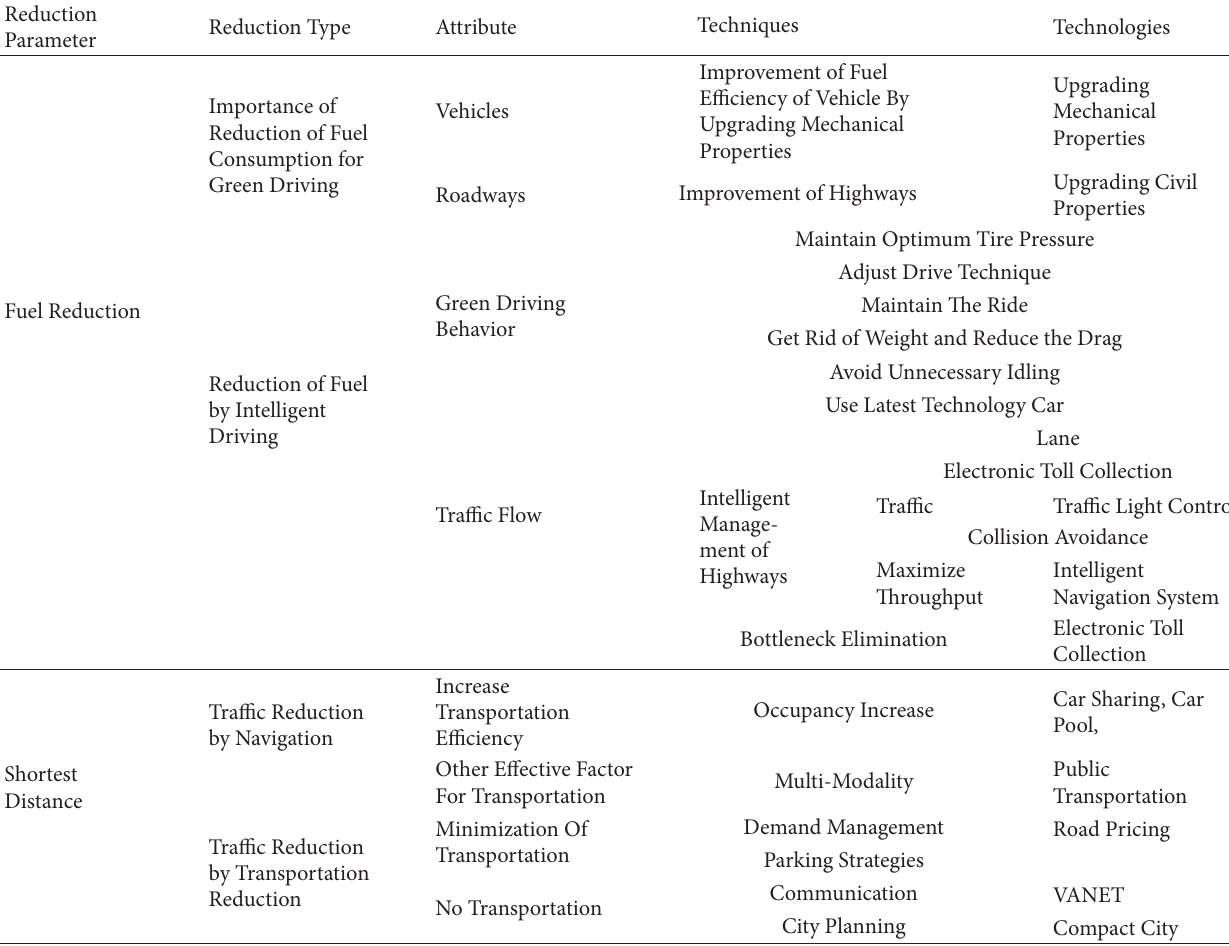
Table 1: Techniques and Technologies for fuel reduction of